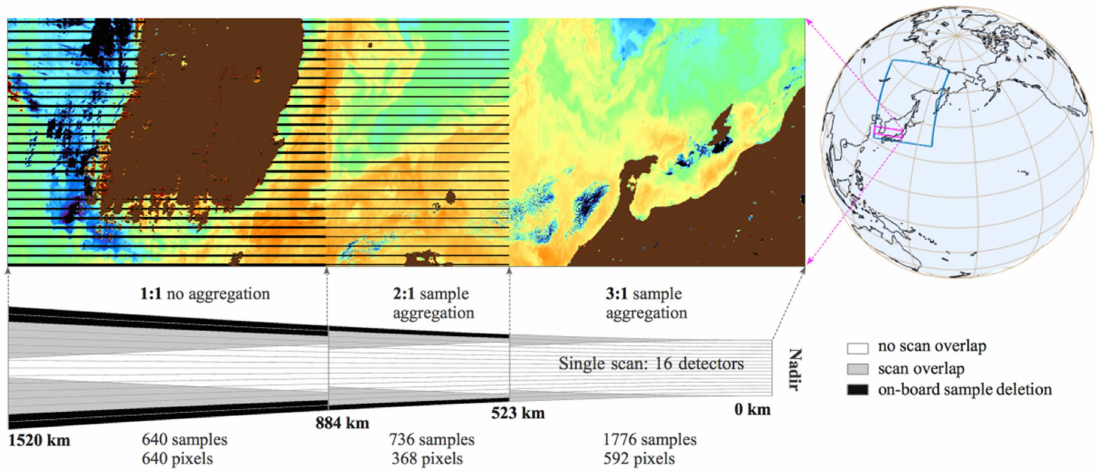
Figure 1. Top-left : Example of bow-tie deletions when the Visible Infrared Imaging Radiometer Suite (VIIRS) sea surface temperature (SST) image is displayed in the original swath projection. Deleted pixels are rendered in black and the land is shown in brown. Top-right : Location of the 10 min Advanced Clear-Sky Processor for Oceans (ACSPO) granule (18 October 2015 UTC) is shown by blue rectangle and its portion, displayed in the top-left, is shown in magenta. Bottom : Schematic representation of the left half of a single scan, showing bow-tie distortions, on-board deletions and aggregation for a single-gain